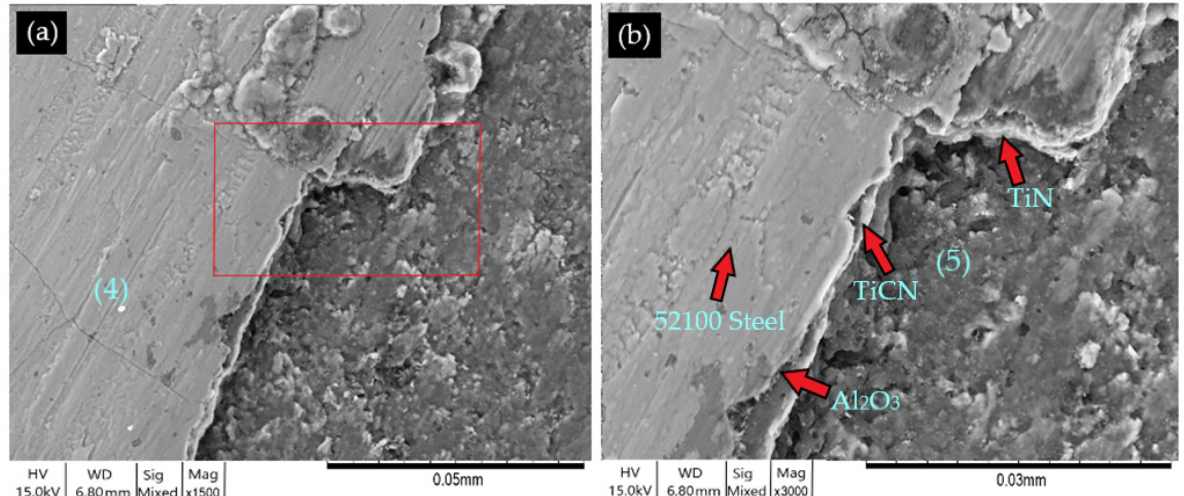
Figure 6. SEM images of Coating A after pin-on-disc Test 1a: ( a ) × 50 magnification, ( b ) × 800 magnification. Red